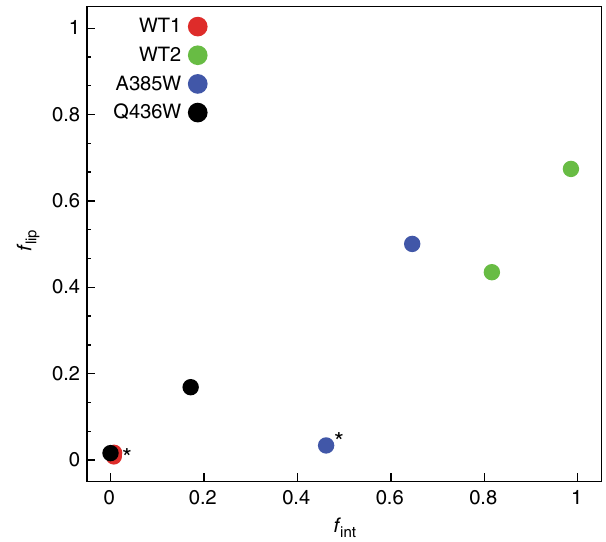
Fig. 5 Switching of R432 from E313 to E318 promotes lipid accumulation near the extracellular side of the groove. Frequency of fi nding two or more lipids ( f lip ) vs frequency of the protein con fi guration in which E313-R432 bond is broken and E318-R432 is formed ( f int ). f int is the calculated fraction of time when the E318-R432 bond was formed (de fi ned by a minimum distance of 3 Å or shorter between these two residues), and the E313-R432 interaction was disrupted (de fi ned by a minimum distance larger than 3 Å between these two residues); f lip is the calculated fraction of time in which two or more lipid headgroups are present near the E313/R432 pair of residues. Each symbol represents a data point for one of the protomers of nhTMEM for a particular construct. Close to linear relationship between f lip and f int is inferred from the linear regression of the data which yielded Pearson correlation coef fi cient of 0.6. A star denotes the data for one of the protomers in the A385W and WT1 constructs with a rare mode of lipid binding in the groove in which lipid tail penetration to the extracellular side of the groove was observed (Supplementary Figure